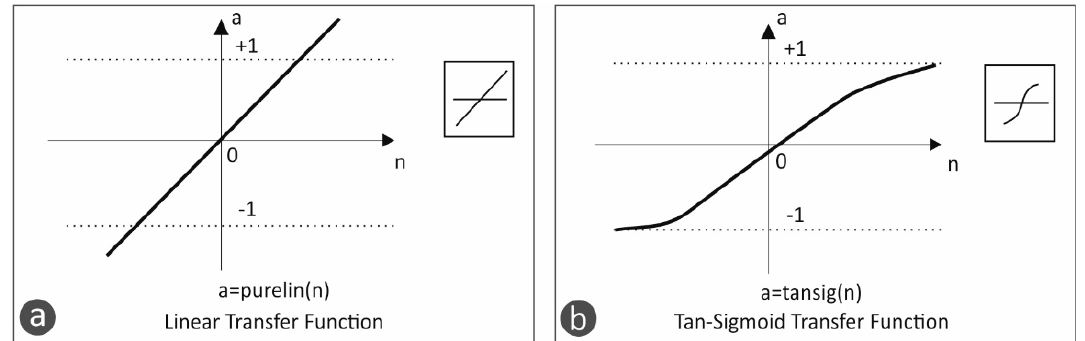
( a ) PURELIN linear transfer function; ( b ) TANSIG hyperbolic tangent sigmoid transfer